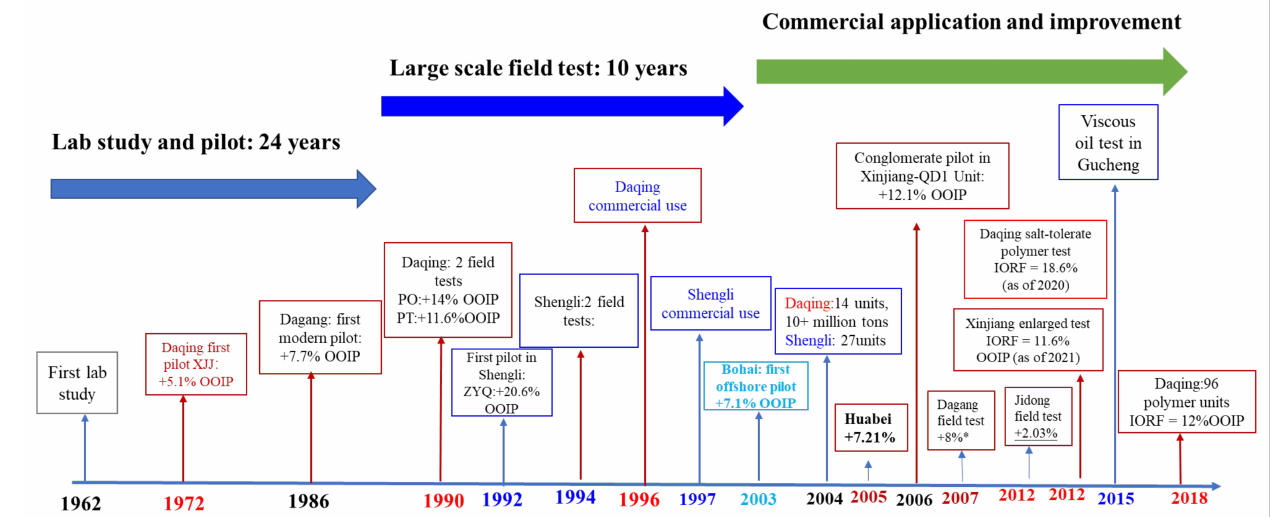
Figure 13. Polymer flooding in China (revised from